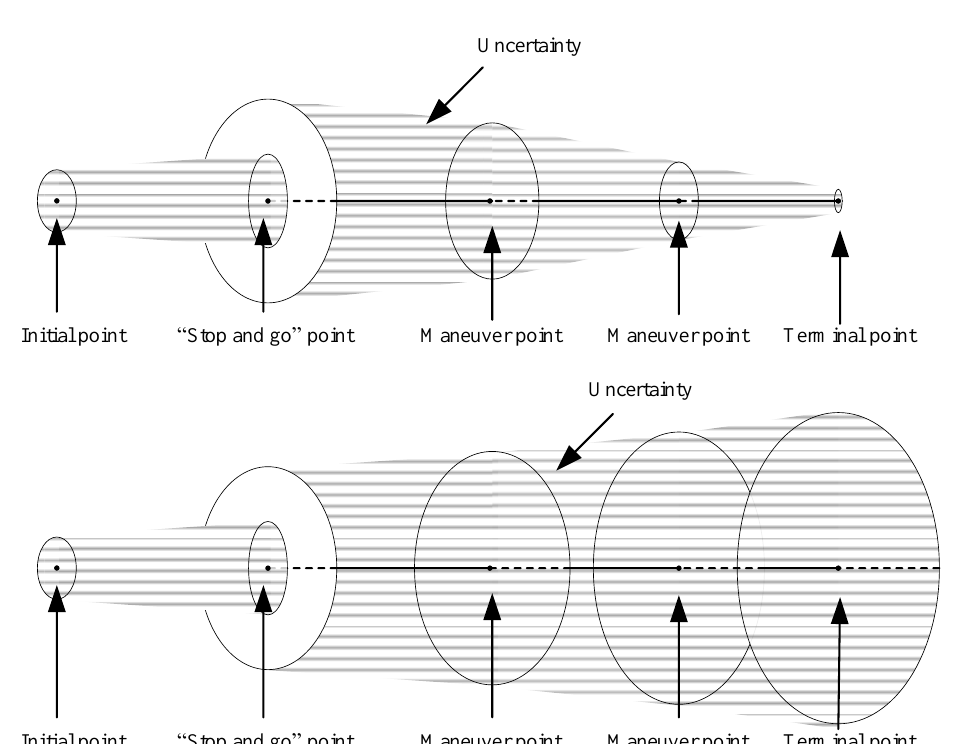
Figure 7. Expected results: the figure above is robust guidance, and the figure below is open-loop guidance.